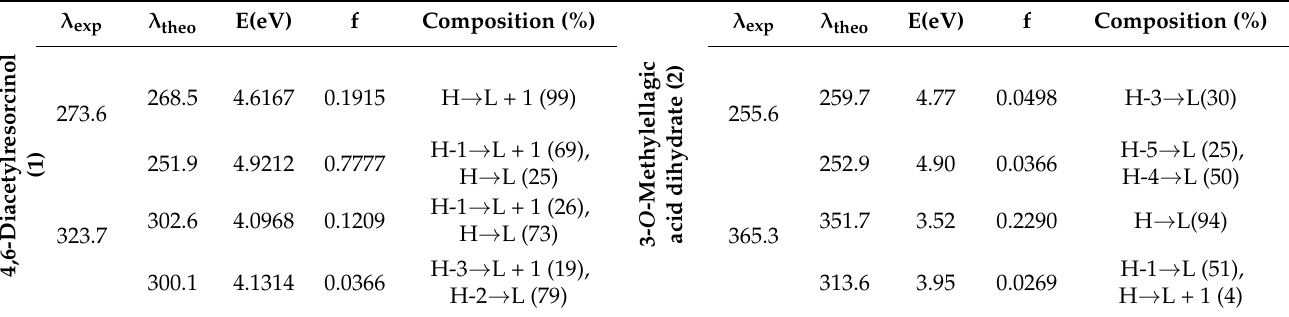
Figure 7. Experimental ( a ) and calculated ( b ) UV-vis absorption spectra of the 4,6-Diacetylresor- cinol.